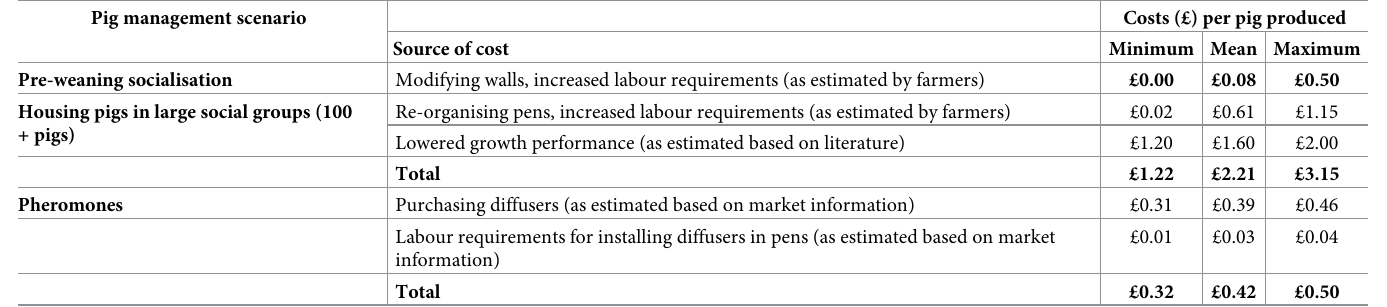
Table 6. The costs of each pig management scenario as included in the stochastic partial budgeting. Pig management